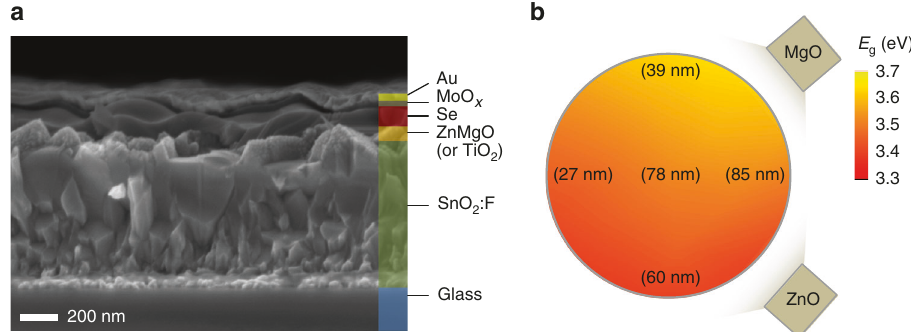
Fig. 1 a Cross sectional scanning electron microscopy of the optimized device structure which consists of glass/SnO 2 :F/n-type buffer (ZnMgO or TiO 2 )/ Se/MoO x /Au. Only 100-nm-thick Se absorber is used. b A schematic of combinatorial sputtering setup for accelerated studies on ZnMgO n-type buffer layers. A color map indicates the band gap ( E g ) of ZnMgO thin fi lms measured by optical absorption spectra. The measured fi lm thickness values in the map indicate a gradient of deposition